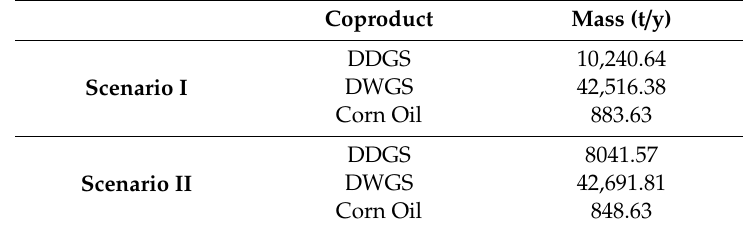
Table 4. Total coproducts produced from the ethanol plant considering the conventional ethanol production (Scenario I) and the flocculation system (Scenario